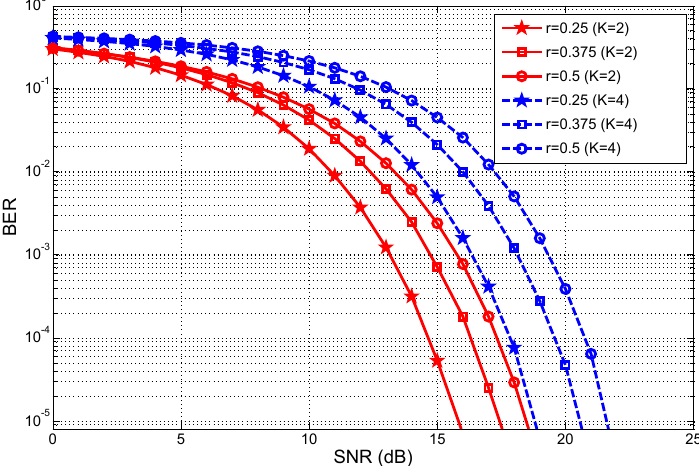
Figure 3. Error performance of the proposed scheme under different dimming